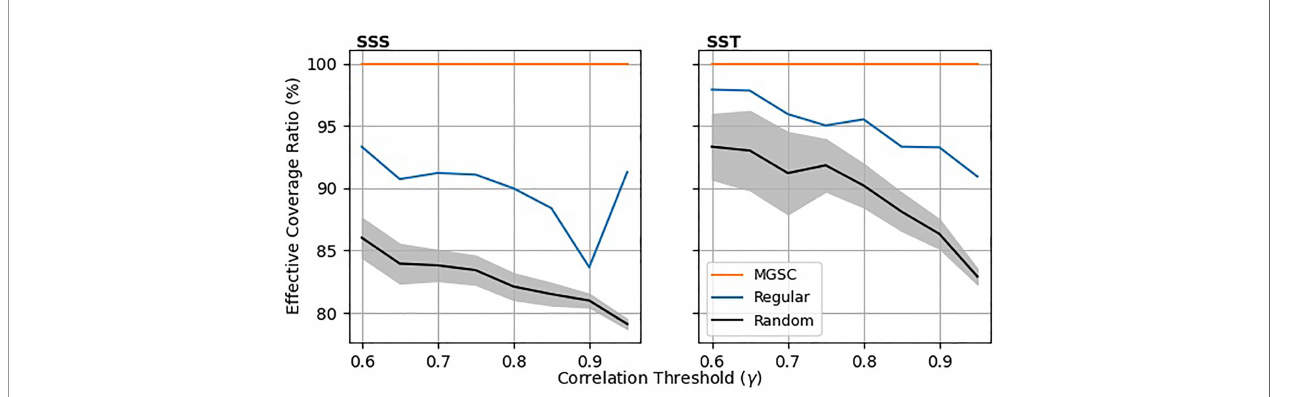
FIGURE 6 | Effective Coverage Ratio (ECR) vs. Correlation threshold g . The MGSC method has been used to generate a set of points for varying correlation thresholds. The corresponding regular and random grids were then generated with equivalent numbers of points. For each grid, the ECR has been calculated by using g as the de fi nition of coverage. For the random placements, lines show the ensemble mean and the shaded areas show 1 standard deviation either side of the mean.